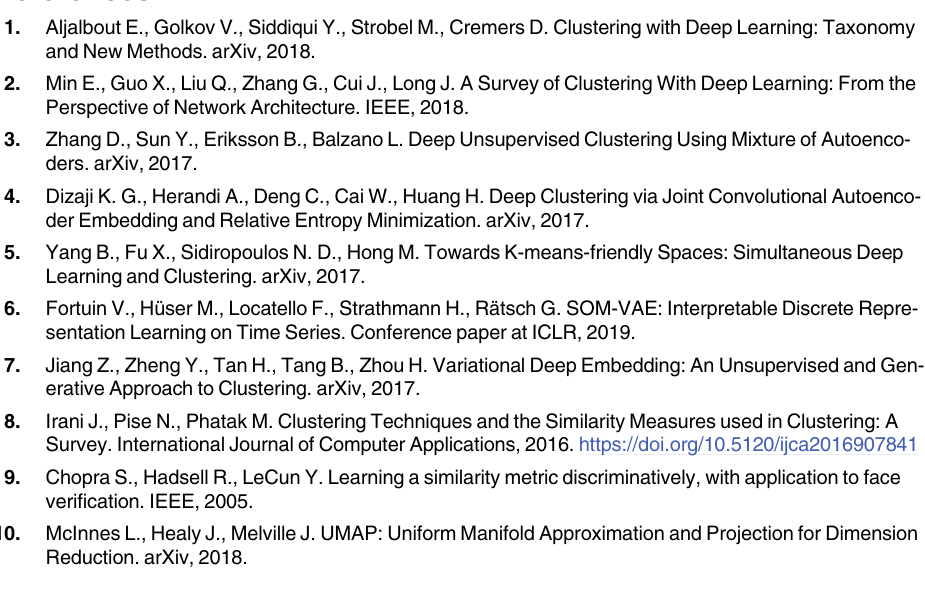
S1 Table. Signature gene accuracy. Accuracy of assigning a organ similarity based on high gene expression of prior selected organ specific signature genes for the split training and test data set. We computed the balanced accuracy for each single organ vs. the rest, respectively. S2 Table. Exact results on 268 mass cytometry experiments. CyTOF measurements from peripheral blood mononuclear cells (PBMCs) were taken and the goal is to define the different cell types present in the data. The ground truth was defined using the SPADE algorithm [48], which can visualize the high dimensional data in such a way to be able to manual gate the cells. We compare to other fully unsupervised methods as FlowSOM, X-shift and PhenoGraph and achieve in most cases the best